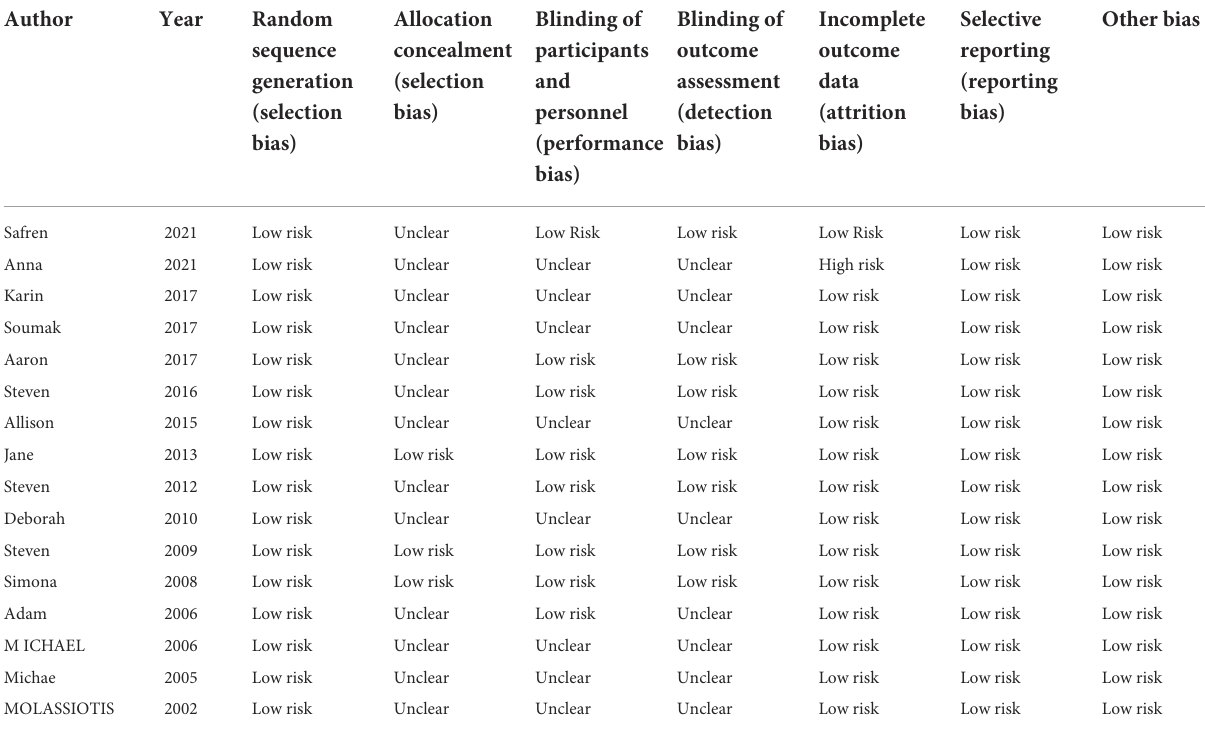
TABLE 2 Methodological quality